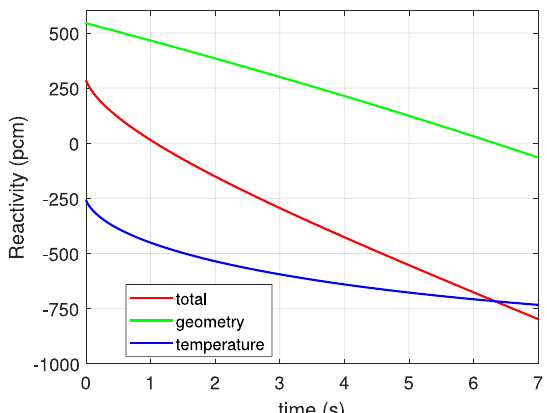
Fig. 6. System reactivity as a function of time during the first 7 seconds of transient. The red, the green and the blue lines rep- resent the total ρ ( h, T ) , the geometry-related ρ h ( h, T ) and the temperature-related ρ T ( h, T ) system reactivities,